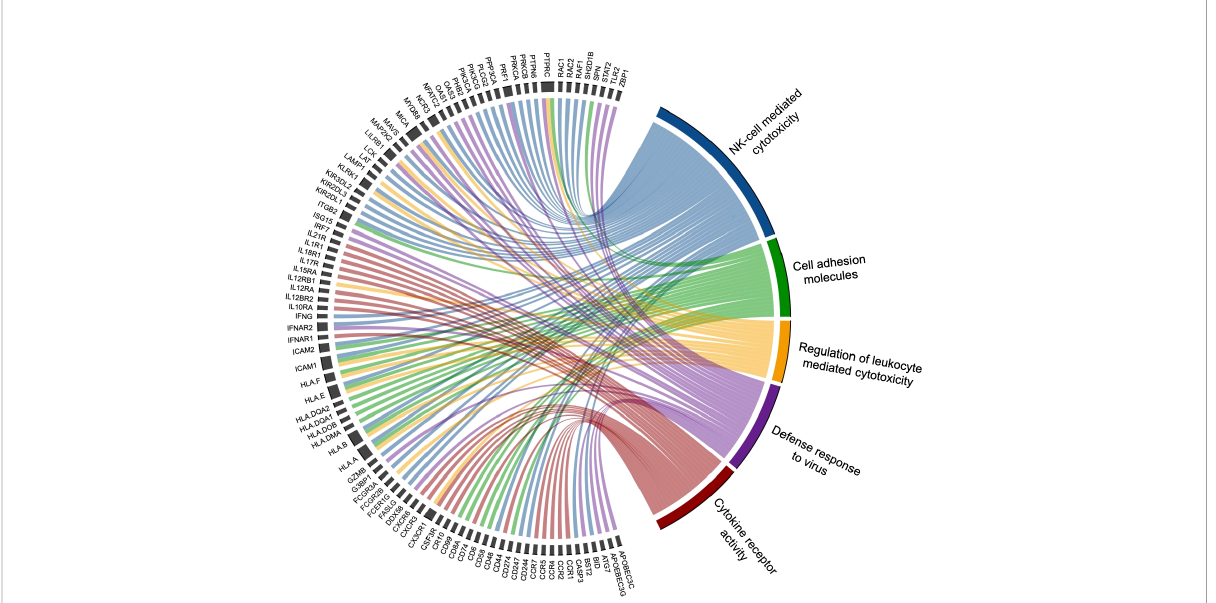
FIGURE 5 Leading edge genes are displayed in this chord diagram to indicate those that signi fi cantly drive the top selected GSEA pathways upregulated by exercise. The fi ve biological processes with associated driving genes include NK-cell mediated cytotoxicity (blue), cell adhesion molecules (green), regulation of leukocyte mediated cytotoxicity (yellow), defense response to virus (purple), and cytokine receptor activity (red). Various genes are found to drive multiple pathways (e.g. perforin 1 [PRF1] drives NK-cell mediated cytotoxicity and defense to virus), while other genes are associated with one biological